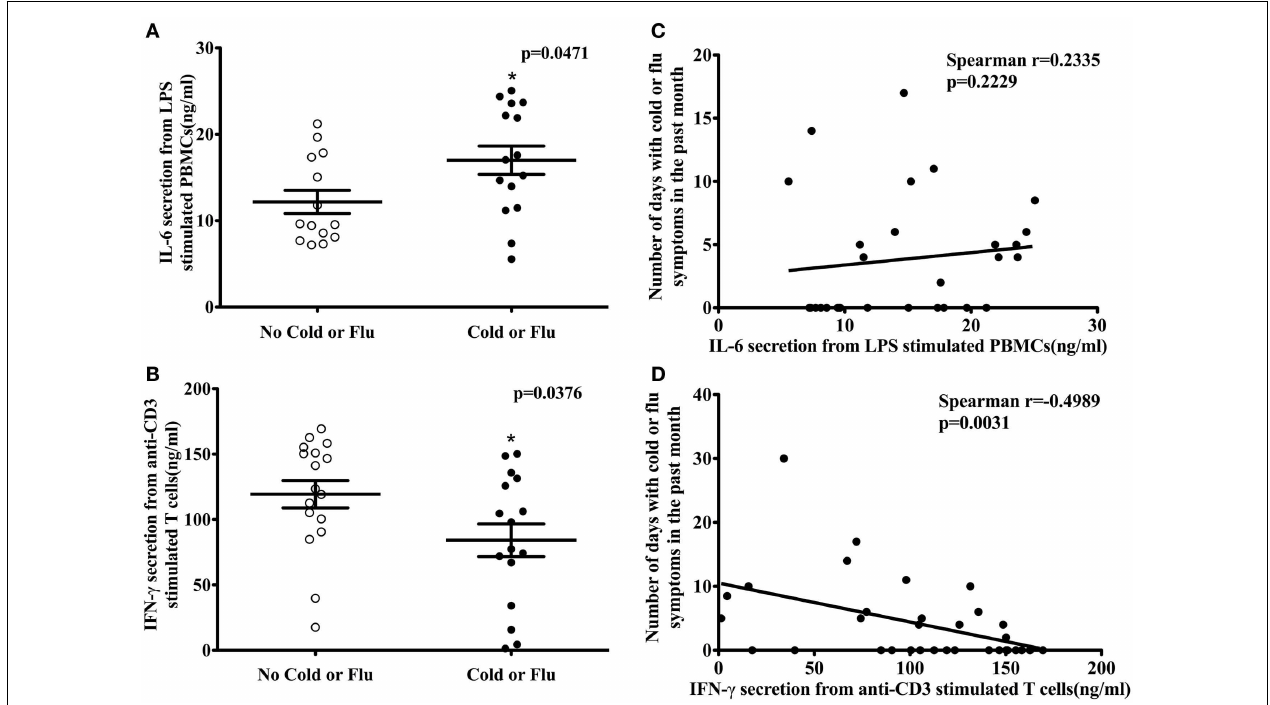
p = 0.2229]. IFN- γ secretion from anti-CD3-stimulatedT cells in subjects with cold or flu symptoms was significantly lower compared to subjects without cold or flu symptoms [ (B) ; unpaired t -test, p = 0.0376].T-cell IFN- γ secretion was inversely associated with total number of days with self-reported cold or flu symptoms [ (D) ; Spearman r =− 0.4989, p = 0.0031]. Asterisk indicates a significant difference from no cold or flu group ( p < 0.05).